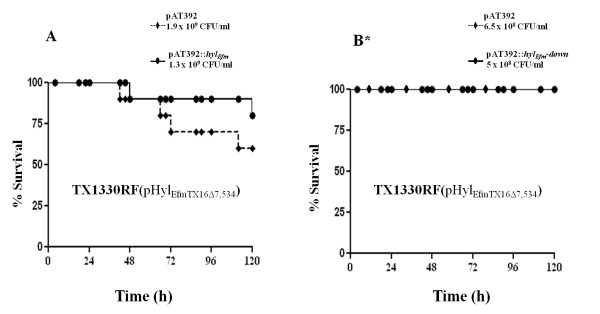
Survival curves in the mouse peritonitis model of E. faecium TX1330RF and derivatives. A and B show survival curves of the TX1330RF(pHylEfmTX16Δ7,534) (6 gene mutant in the hylEfm region) complemented with pAT392-derivatives (which include pAT392::hylEfm and pAT392::hylEfm-down) obtained in the peritonitis model at different inocula in independent experiments performed at different days. The asterisk indicates that the lines are superimposed since values are identical.